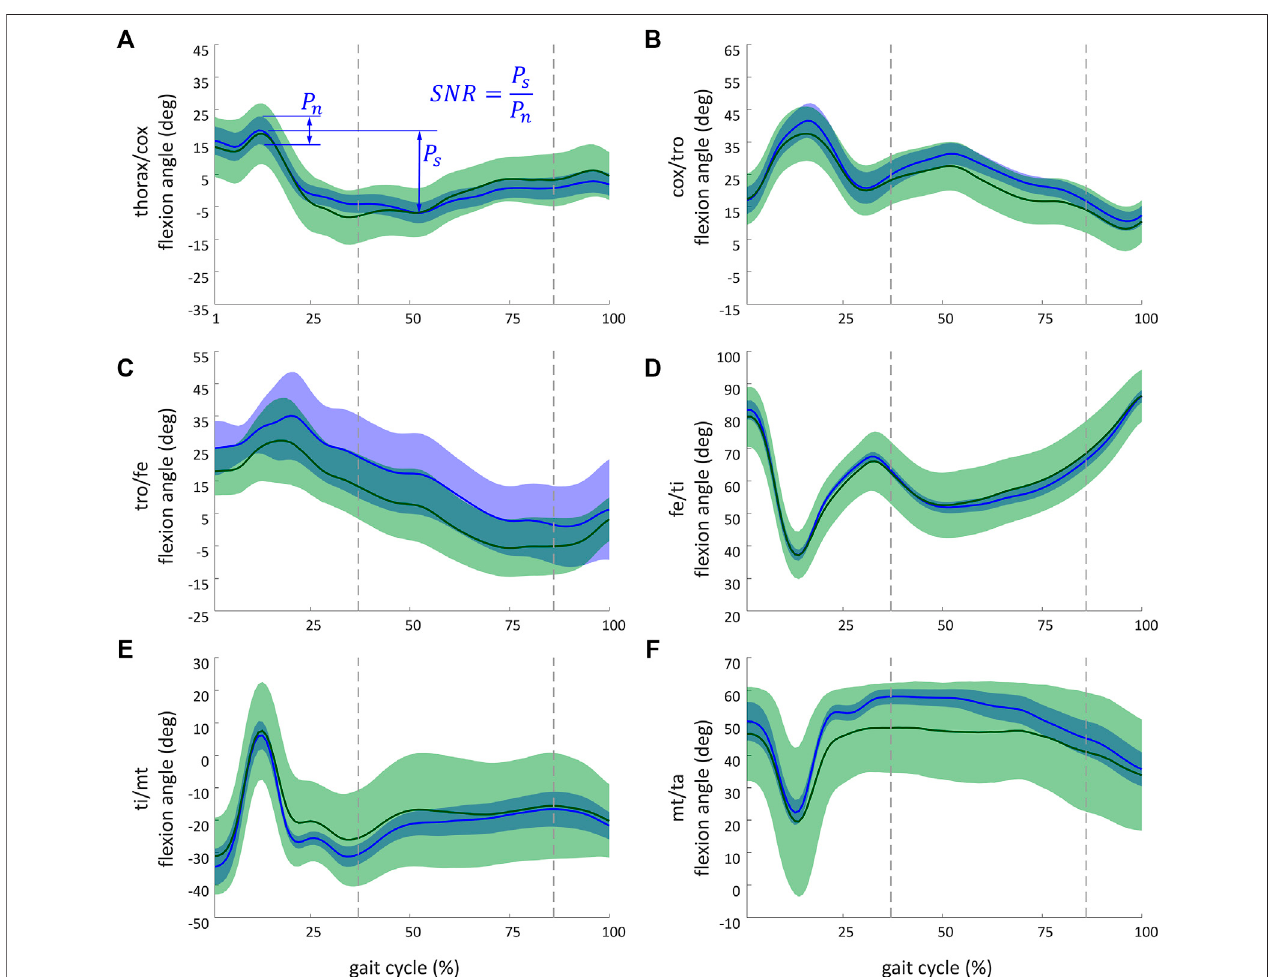
FIGURE 7 | Kinematic results obtained from the simulation of the ant model and the experimental kinematic data for fl exion angle of the middle right leg of (A) thorax/cox; (B) cox/tro; (C) tro/fe; (D) fe/ti; (E) ti/mt, and (F) mt/ta. The recorded and simulated gait cycles lasted 1.39 s. These results are a sample of the whole set of results availablefromtheprojectrepository.Solidlinesindicate themeanvaluesfromtheMonteCarlosimulationsfromthemarkerperturbation (green)andfrom theaxis perturbation (blue). For marker and axis perturbations, respectively, the green- and blue-shaded regions represent the con fi dence interval (calculated as twice the standard deviation). The dashed vertical lines (37% and 87%) indicate when legs of both tripods were on the ground. The SNR of the thorax/cox fl exion angle obtained from the axis perturbation simulation is illustrated in (A) . P s (standing for power of the signal) corresponds to the peak-to-peak amplitude of the signal. P n (standing for power of the noise) corresponds to the maximal coverage interval of the joint angle during the